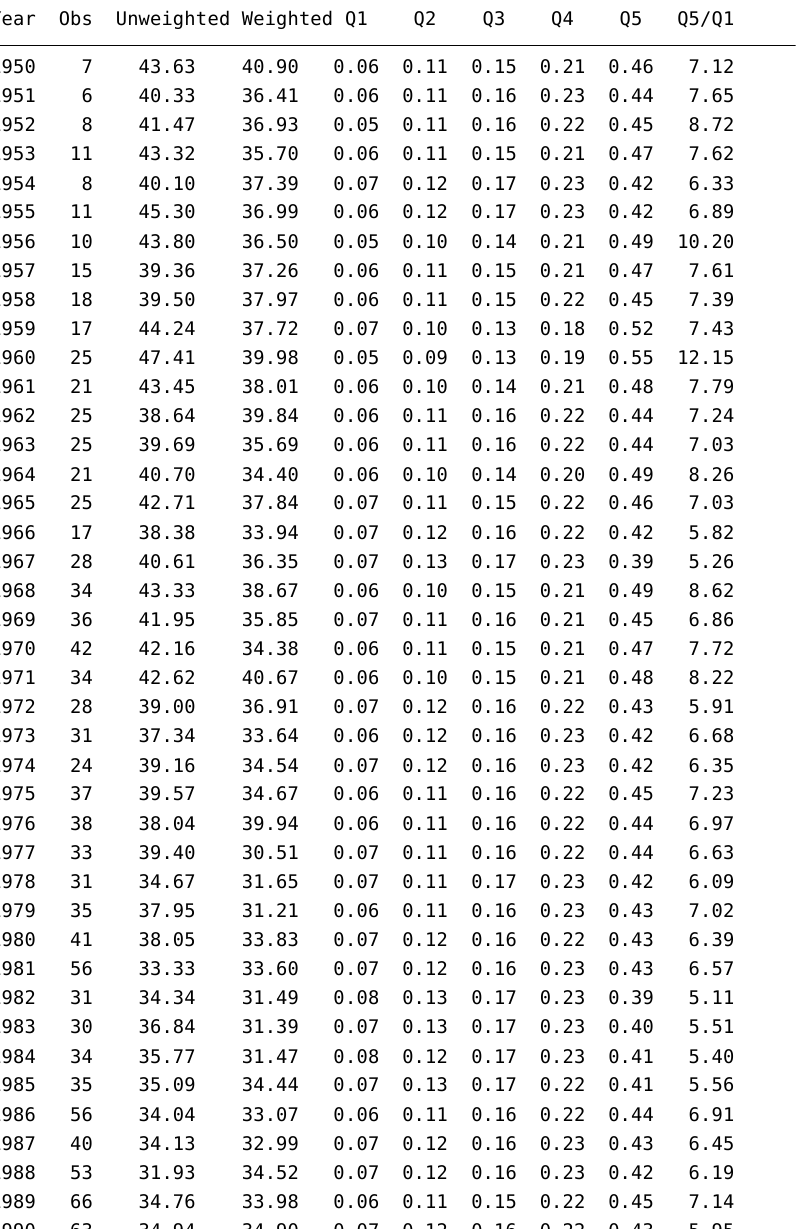
Table 3 – Development of the Global Gini Coefficient and the Distribution of Income Share over